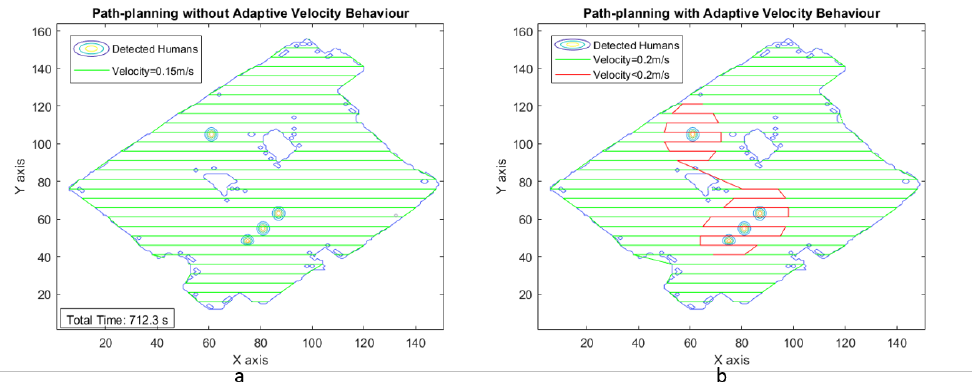
Figure 11. Zig-zag-based area coverage path generated for scenario I. The estimated time taken to cover the region with a uniform velocity model with a velocity of 0.15 m/s is around 712.3 s. The energy consumption for the entire area coverage process for the conventional cleaning method is 1.4958 Ah of the total battery capacity of 36 Ah. Figure 12a–c shows the plot between velocity and grid cell position on the map for the case of adaptive velocity behavior model with linear, tanh, and sigmoid functions. The results validate that time taken to cover the area for the scenario I is less for the adaptive velocity behavior model based on the sigmoid function, and the energy consumption is almost similar for all three adaptive velocity functions. The lowest energy consumption reading is recorded for the sigmoid-based behavior model with 1.1804 Ah, which is 3.27 percent of the total battery